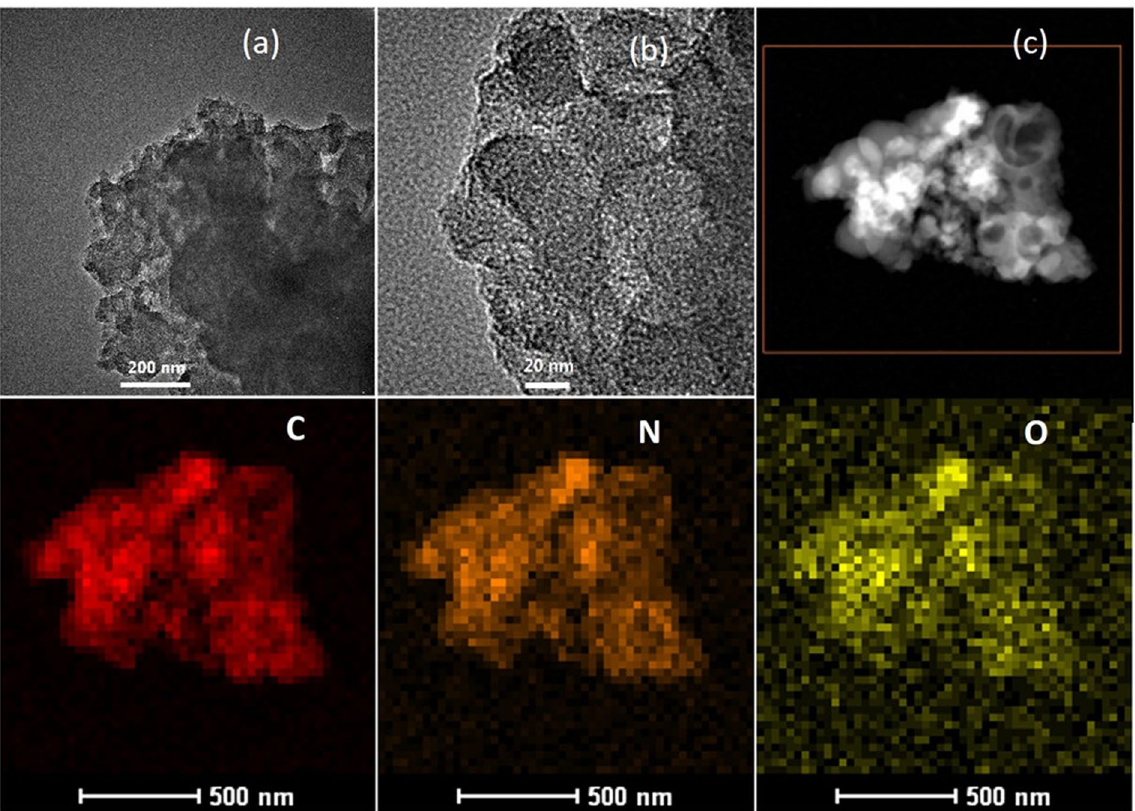
Figure 3. Representative TEM images of BFH-850 ( a , b ), HAADF-STEM image ( c ) and corresponding mapping of carbon, nitrogen and oxygen of BFH-850.